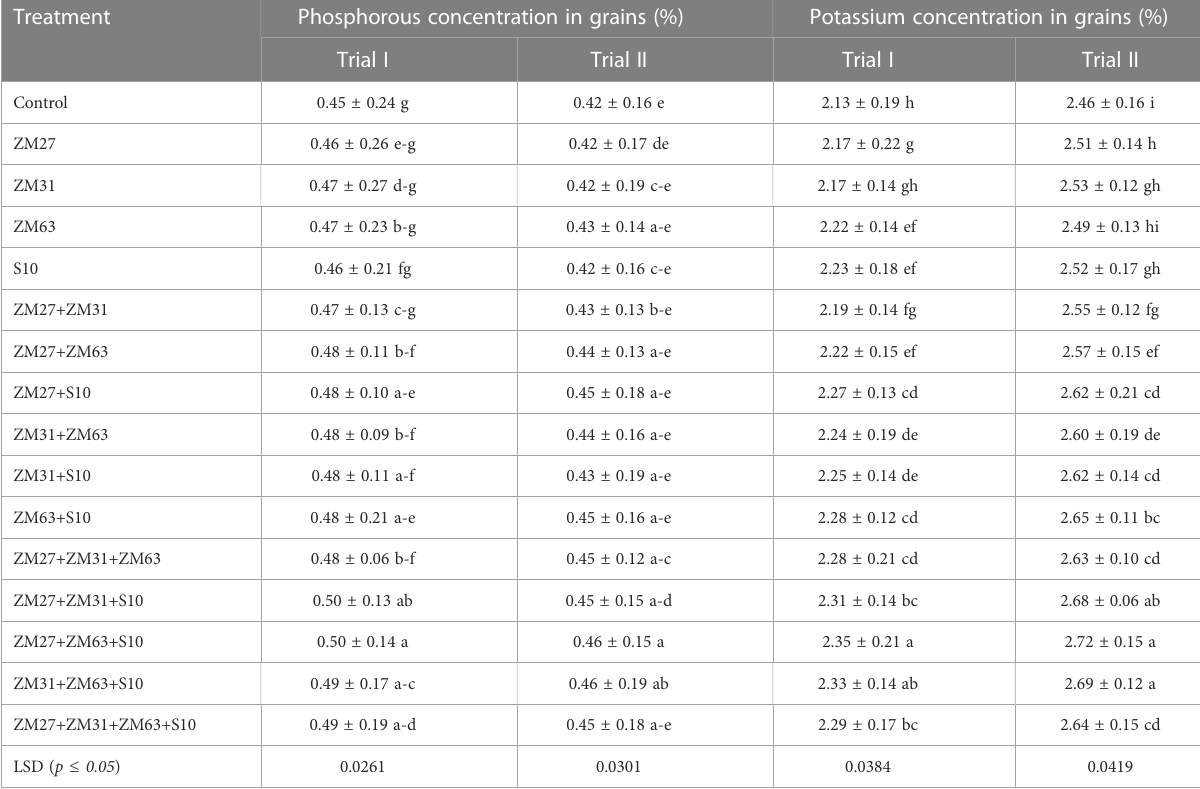
TABLE 7 Effect of novel bio inoculants on phosphorous and potassium concentration in the shoot of maize in fi eld trials.